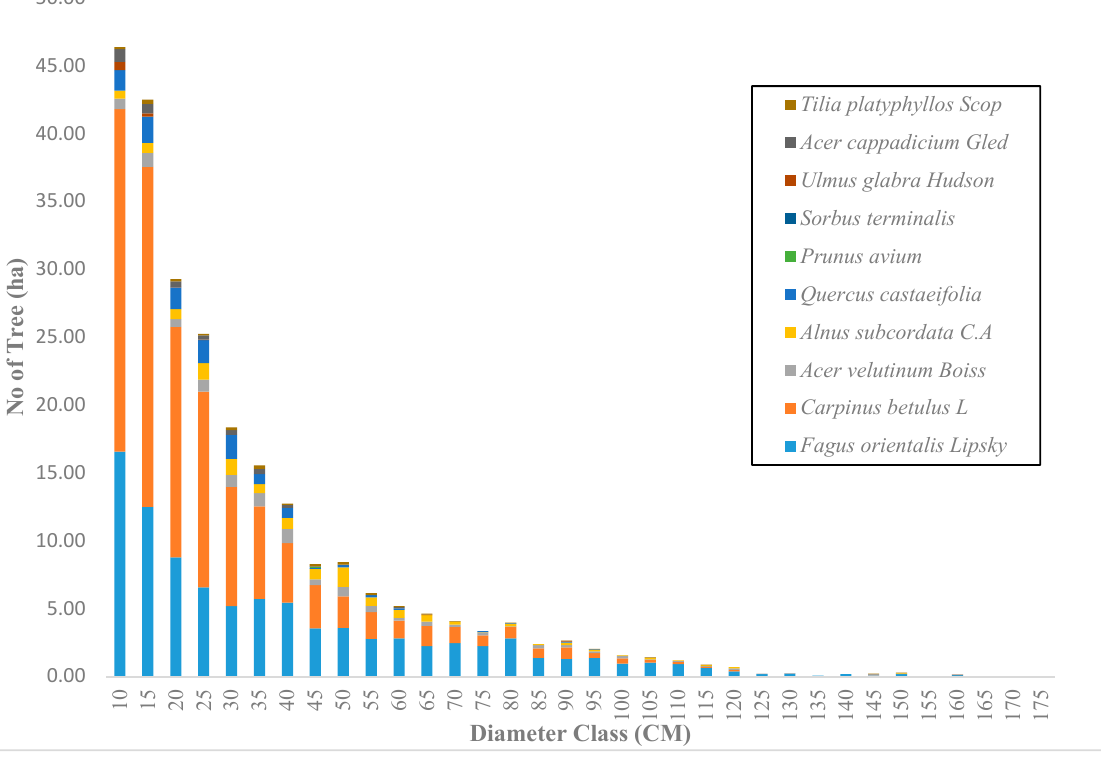
Figure 5. The diameter distribution for uneven-aged and mixed forests in the Gorazbon section in year 2012.